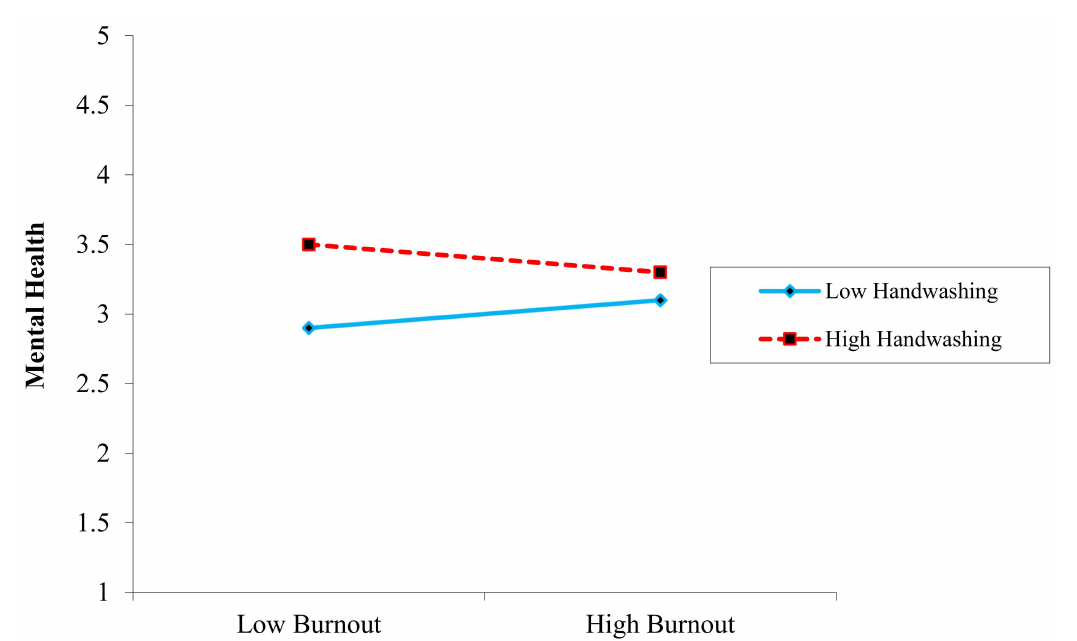
Figure 3. Moderating the role of handwashing on the relationship between burnout and mental